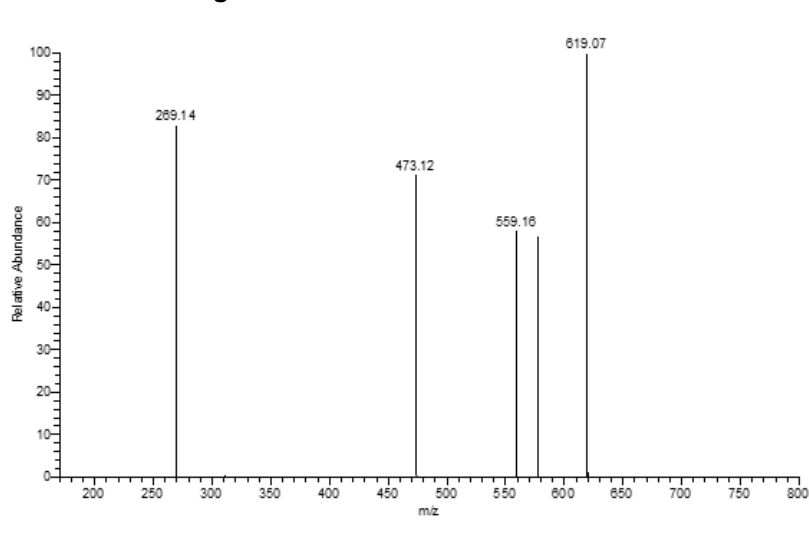
Figure 4. ESI-MS 2 of camellianin